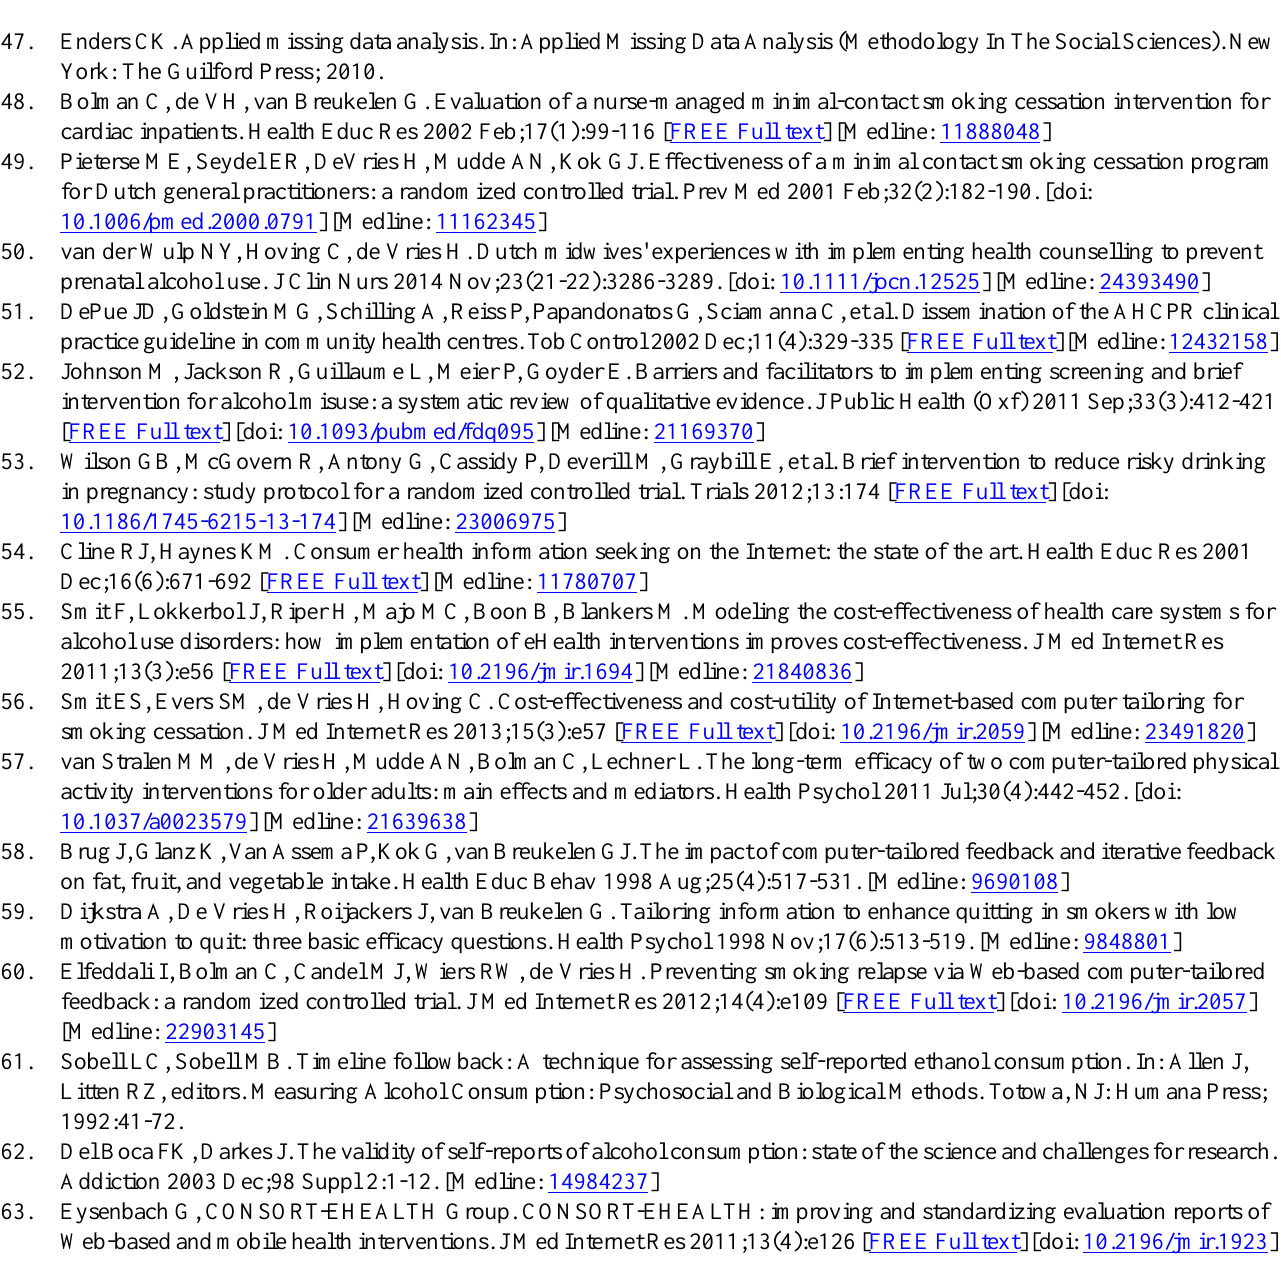
[Medline: 22209829] Abbreviations ICC: intraclass correlation coefficient MAR: missing at random QFV: